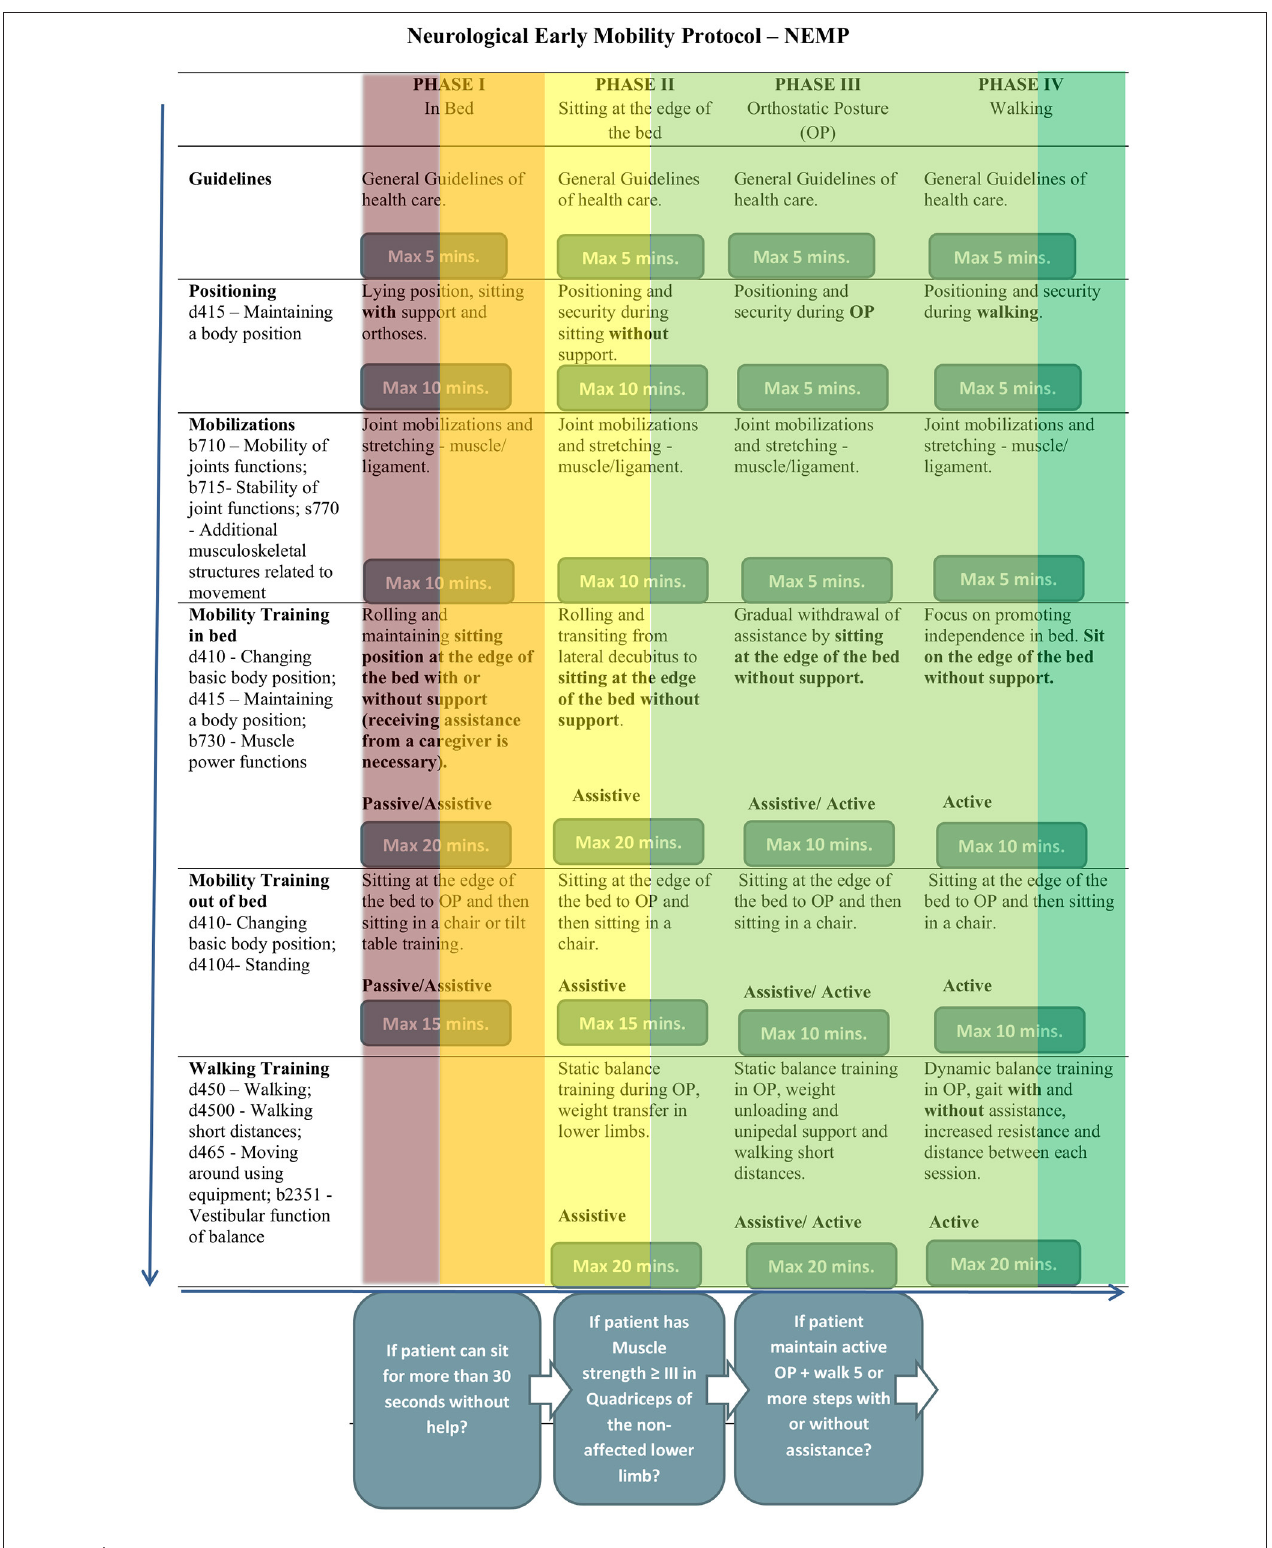
FIGURE 1 | Neurological early mobility